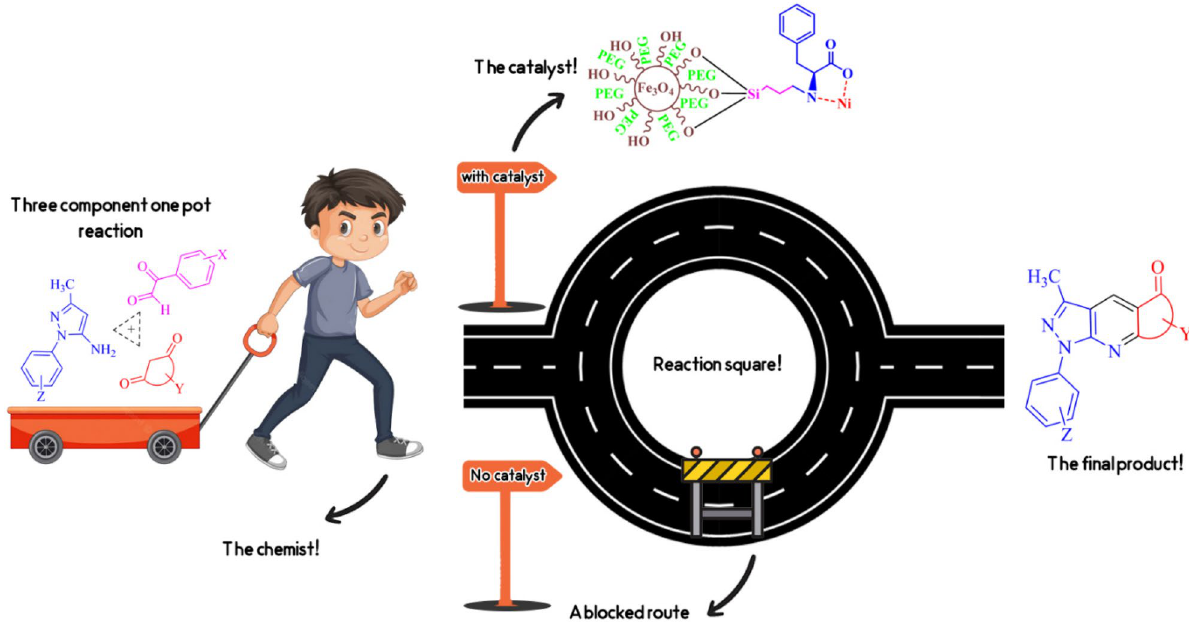
Figure 2. Synthesis of pyrazole derivatives with Fe 3 O 4 @CPTMO-phenylalanine-Ni as a catalyst. (Drawn by Photoshop 2015 and ChemDraw 20.1.1 Cliparts used from